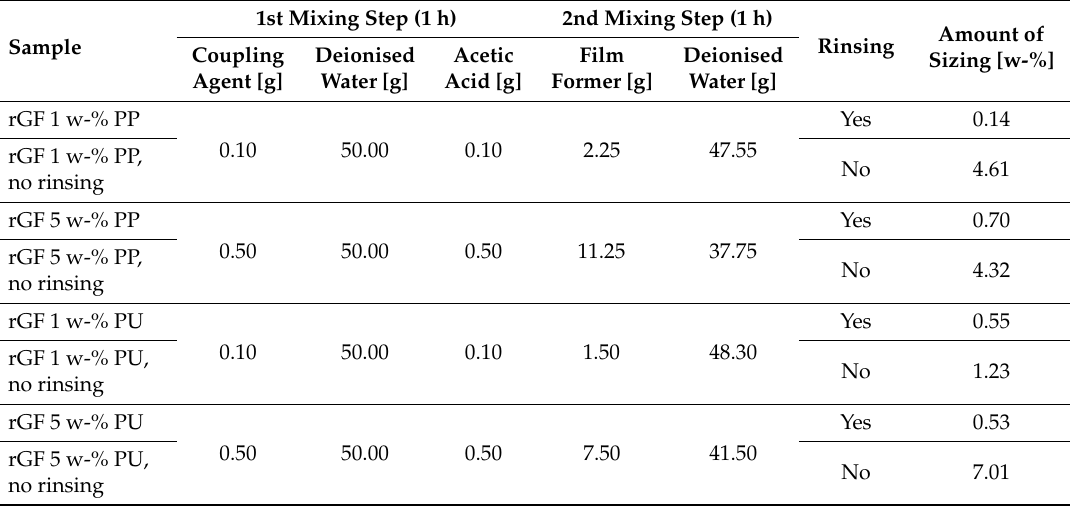
Table 2. The rGF sizing solution formulations for 1 and 5 w-% solid content solutions and the related process steps together with the amount of sizing obtained from thermogravimetric analysis (TGA).